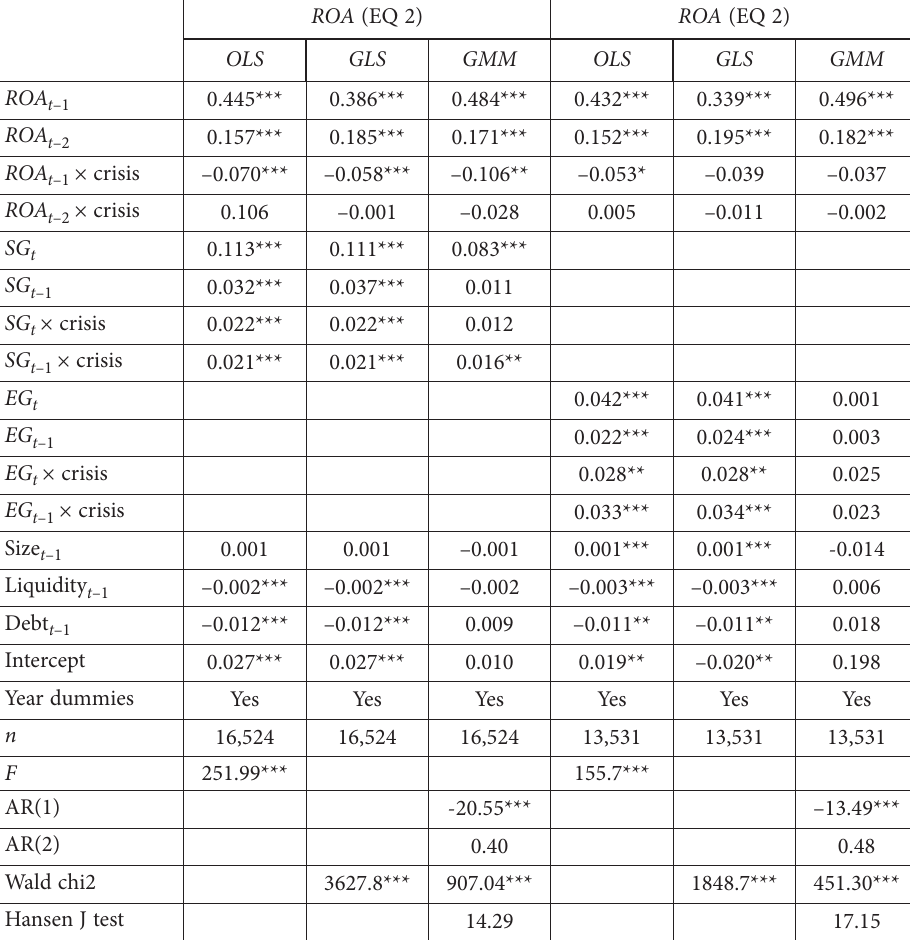
Table 5. Results of the panel estimation: profitability